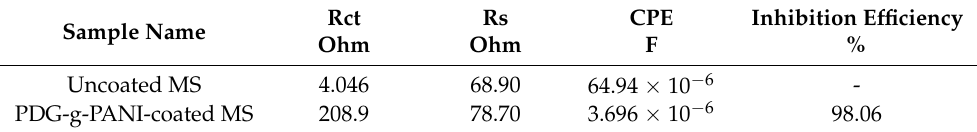
Table 1. Parameters obtained from Nyquist plot fitting of uncoated and coated MS.